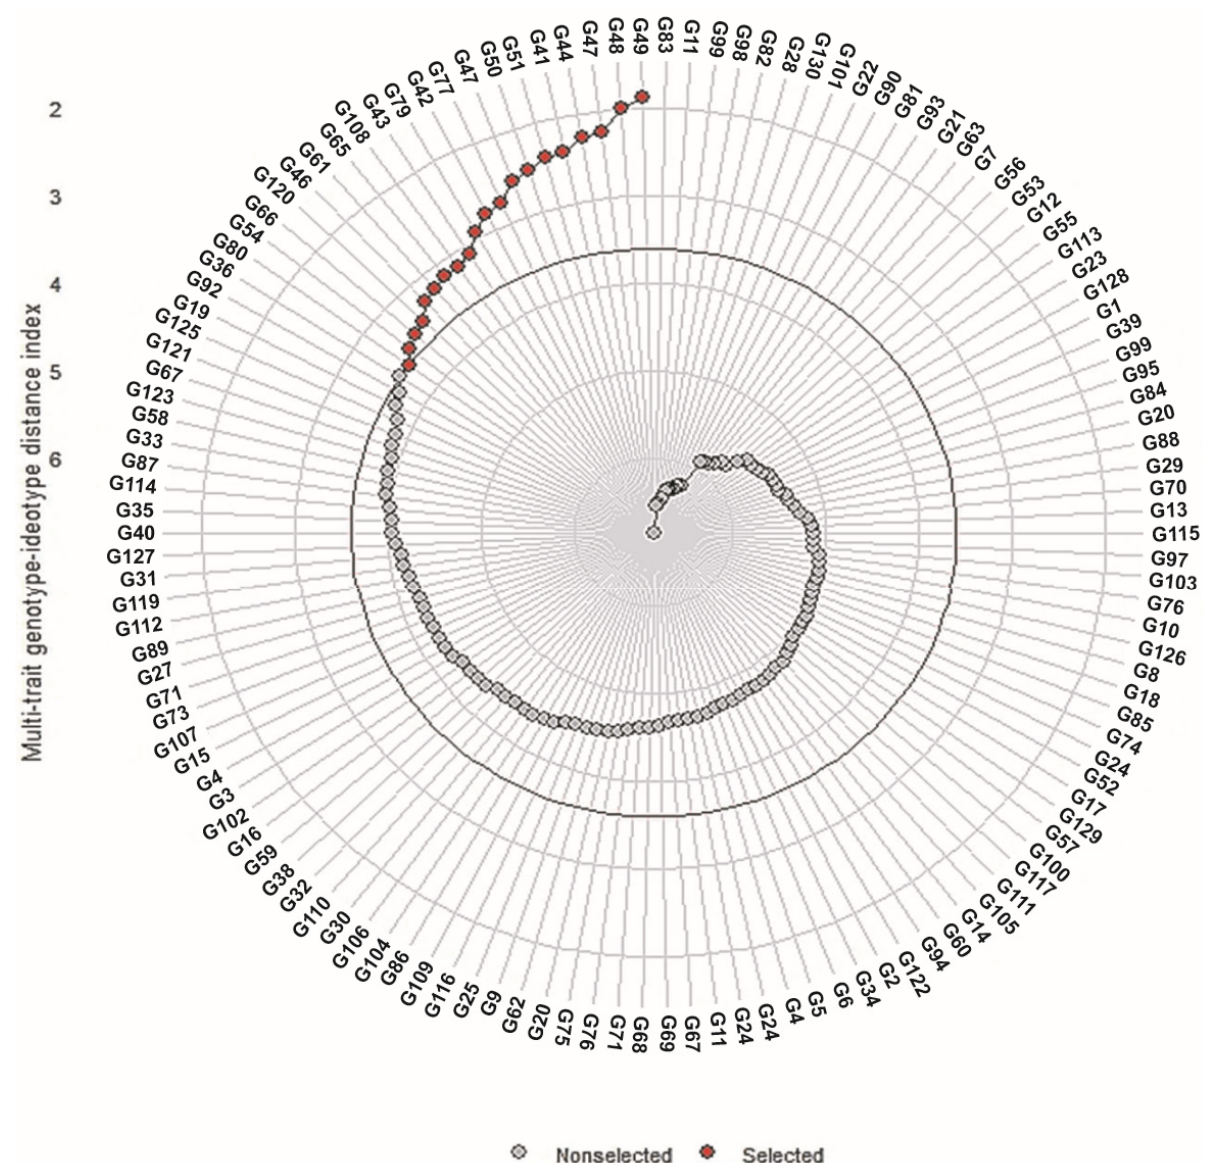
Figure 6. Germplasm ranking and selected germplasm from 130 local germplasm through multi-trait genotype-ideotypes distance index (MGIDI) considering 15% selection intensity.